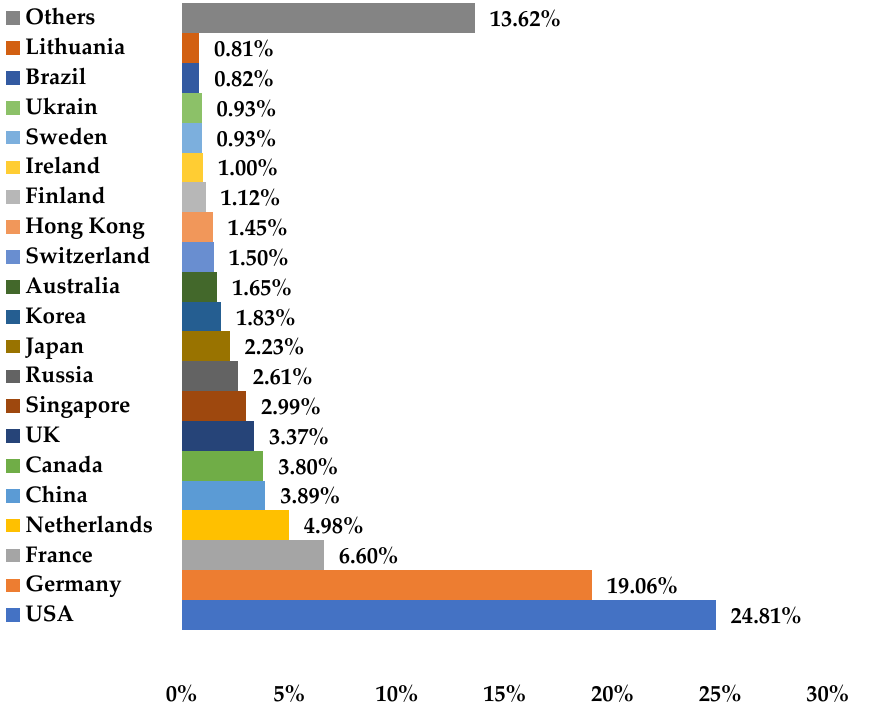
Figure 4. Percentage of total Bitcoin nodes. Source: https://thenextweb.com/ (accessed on 1 September 2021). Note: This figure highlights countries with highest to lowest nodes around the globe. USA and Germany are the leader of Bitcoin node around the globe and including France they are holding over half of world Bitcoin nodes.